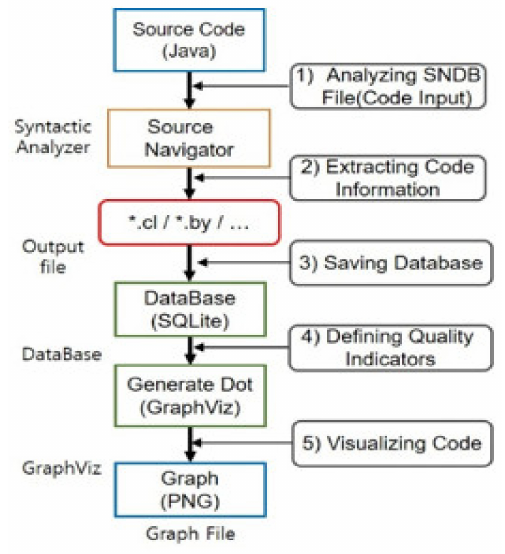
Figure 2. Code visualization process.